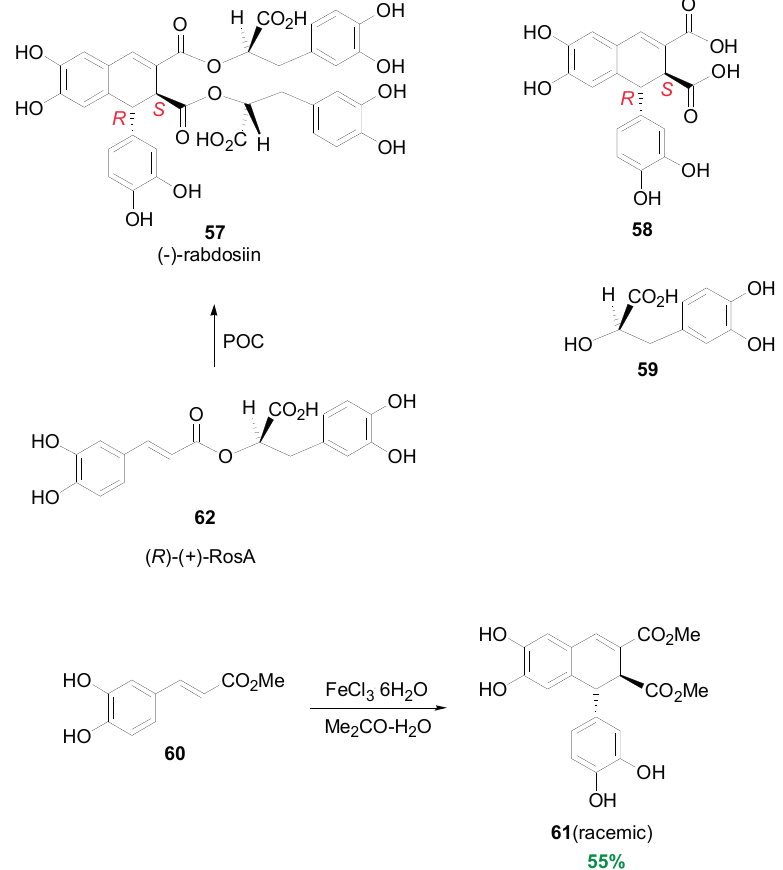
Scheme 32. POC of Me-Caf ( 60 ) using FeCl 3 as oxidant and the structures of rabdosiin